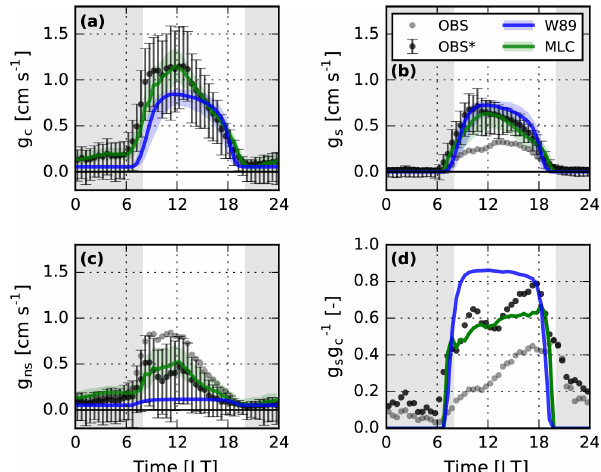
Figure 5. April–September median diurnal cycles of ozone bulk canopy conductance (a) , canopy stomatal conductance (b) , bulk non-stomatal conductance, and (c) the stomatal fraction of total ozone removal ( g s g − 1 c ; d ) for Ispra. Observed medians and in- terquartile ranges after Q gap correction (OBS ∗ ; see text) are shown as black points and whiskers (the values prior to Q gap correction, denoted as OBS, are shown in gray). The median and interquartile range of W89 and MLC-CHEM are shown in blue and green, re- spectively. The shaded area in panel (d) highlights the nighttime period (defined as 08:00–20:00LT) during which the stomatal flux is